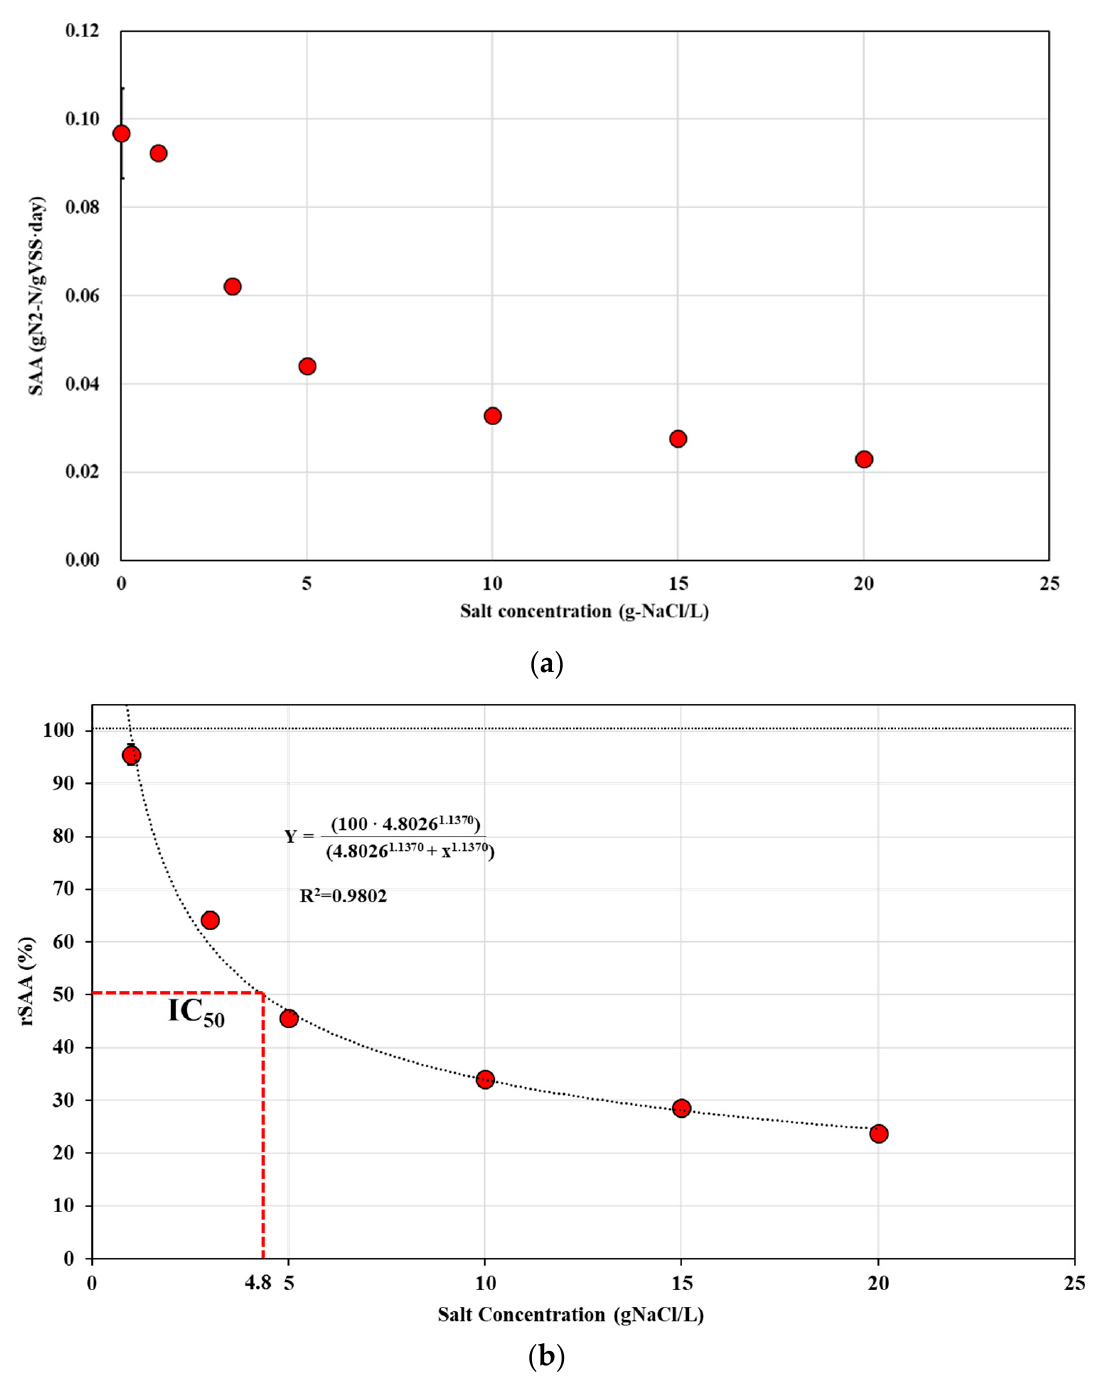
Figure 1. Effect of the salt concentration (g NaCl/L) on the specific anammox activity (rSAA, gN 2 -N/gVSS-day) ( a ) and relative specific anammox activity (rSAA, %) ( b ).